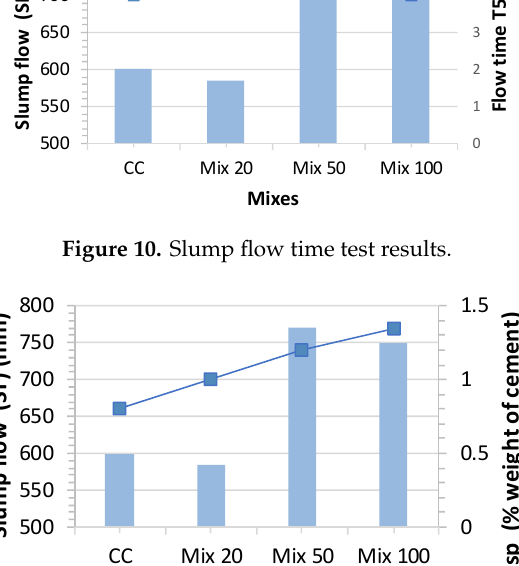
Figure 12. PJ and T 500 results. The classification obtained for concrete as per the criteria found in EHE-08, Annex 17 [31] and standard EN 12350-8:2011 [46] would be as follows: -